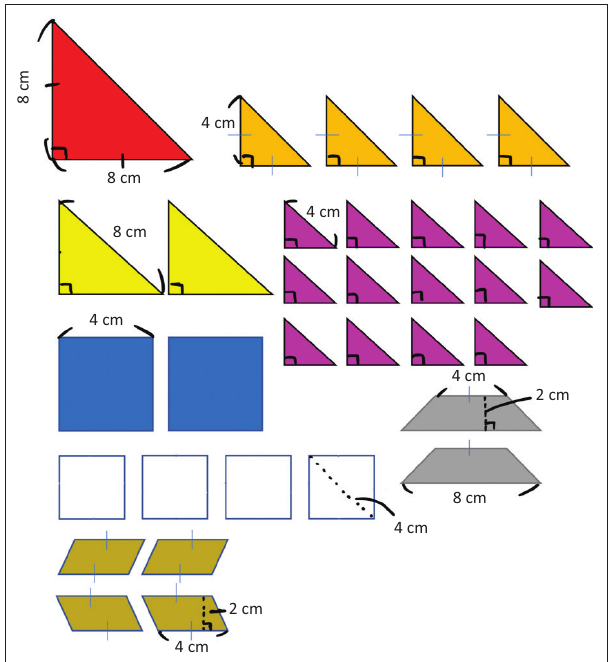
FIGURE 1: The colour boards prepared for the